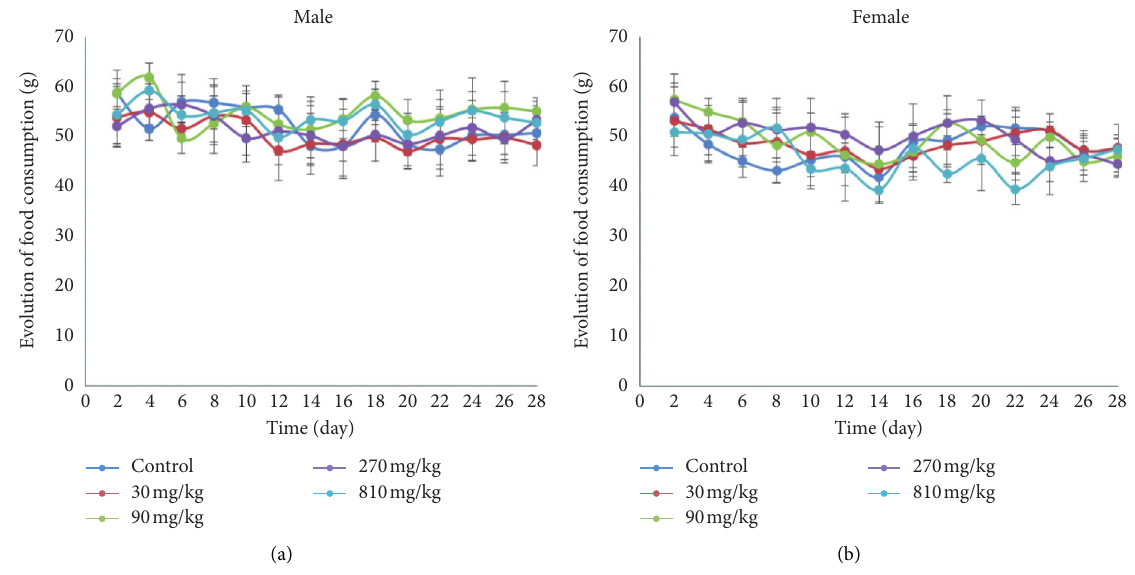
Figure 2: Effect of subchronic administration of aqueous extract of T. grandis on food consumption of rats. Data are expressed as mean ± SD, n � 4. Values for a given group in a column followed by a different letter as superscript are significantly different according to Waller–Duncan’s multiple comparison test ( p < 0.05). (a) Males. (b)